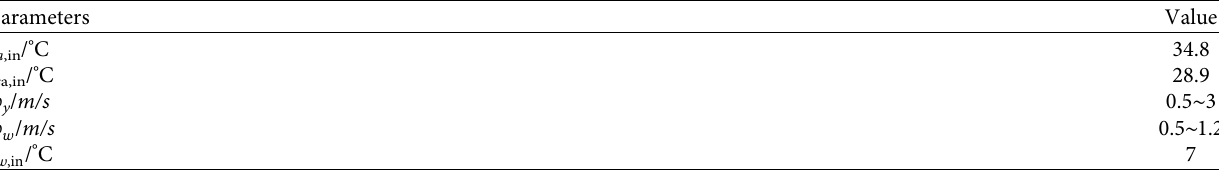
Table 1: Experimental test condition.